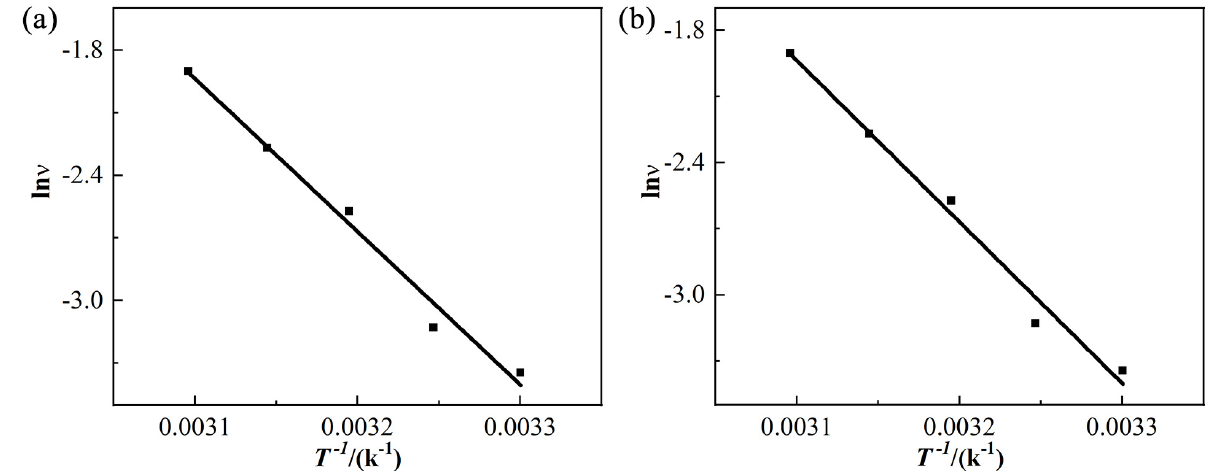
Figure 12. Comparison of corrosion activation energy; ( a ) ln ν and 1/T diagrams of blank water samples; ( b ) after adding copolymers .